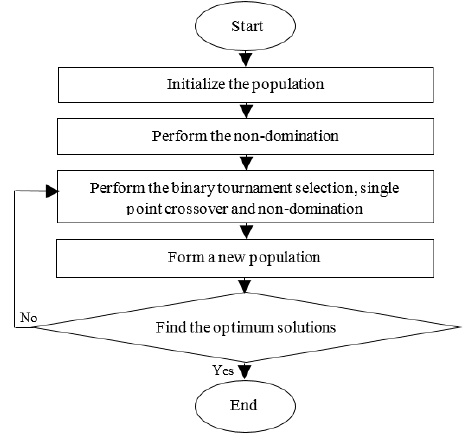
Figure 4. The flowchart of NSGA 𝜫